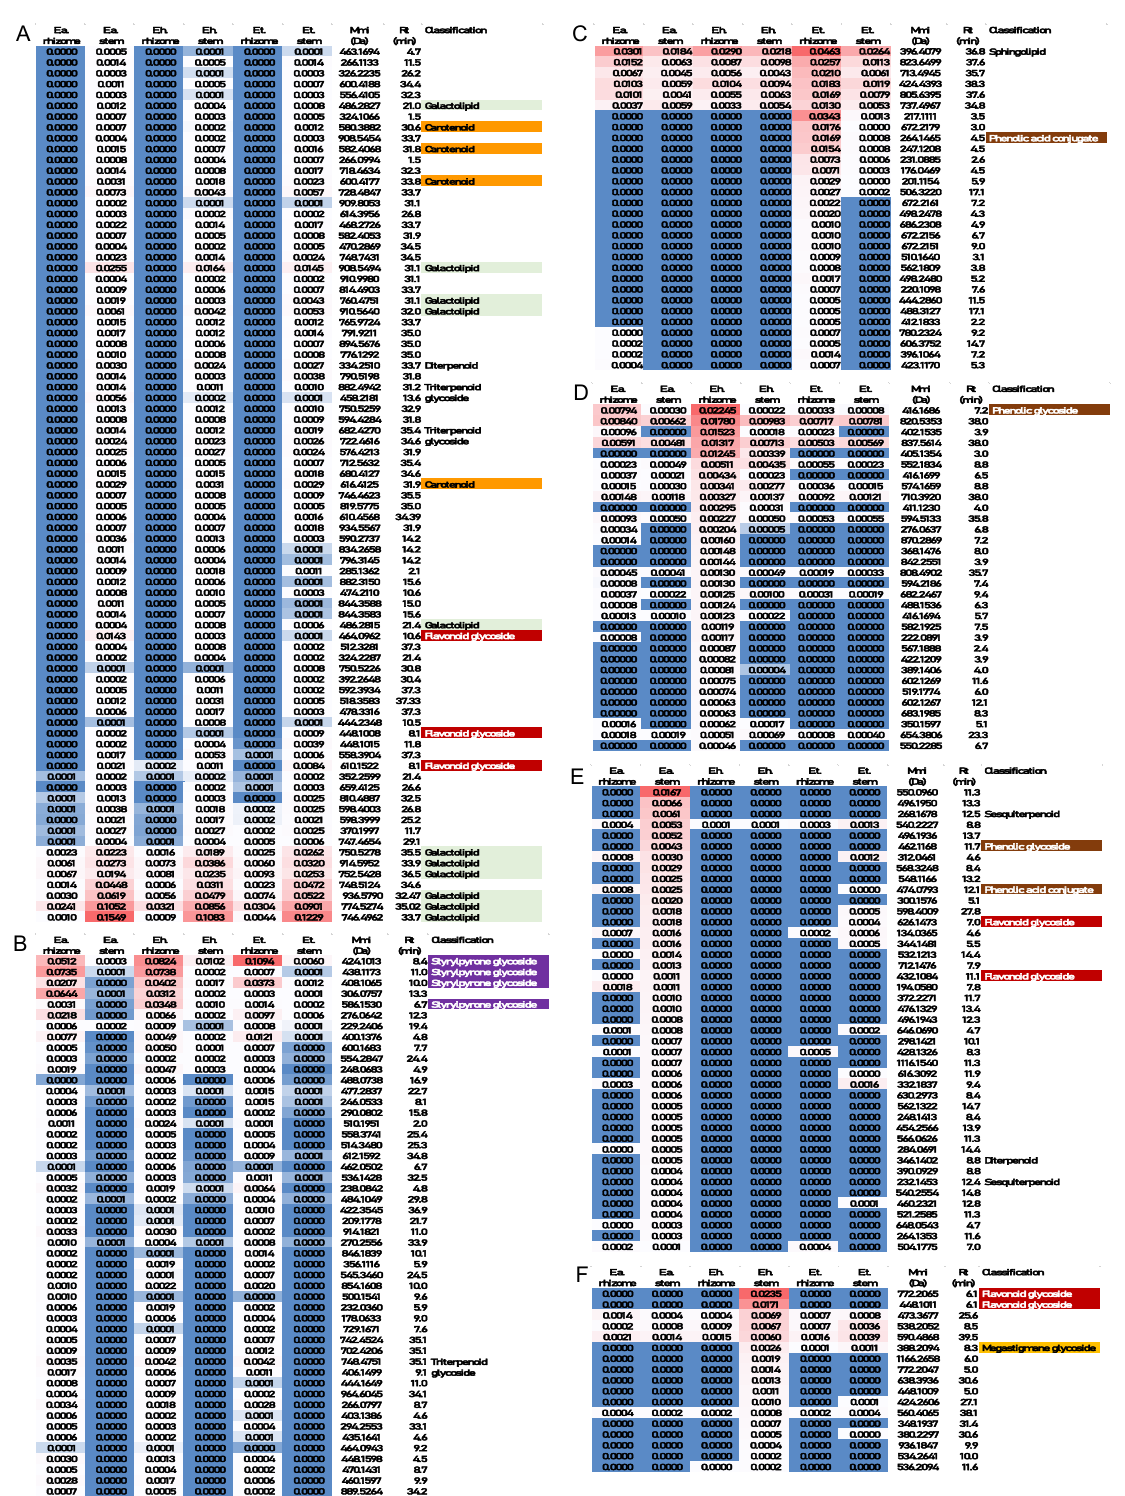
Figure 3. Classification of molecular features contributing most strongly to Equisetum sample group separation in PCA, organized by patterns of accumulation: ( A ) highly positive PC1 scores; ( B ) strongly negative PC1 scores; ( C ) highly positive PC2 scores; ( D ) strongly negative PC2 scores; ( E ) highly positive PC3 scores; ( F ) strongly negative PC3 scores. Abbreviations: E.a., Equisetum arvense ; E.h., Equisetum hyemale; E.t., Equisetum telmateia ; m / z , mass-to-charge ratio; Rt, retention time.